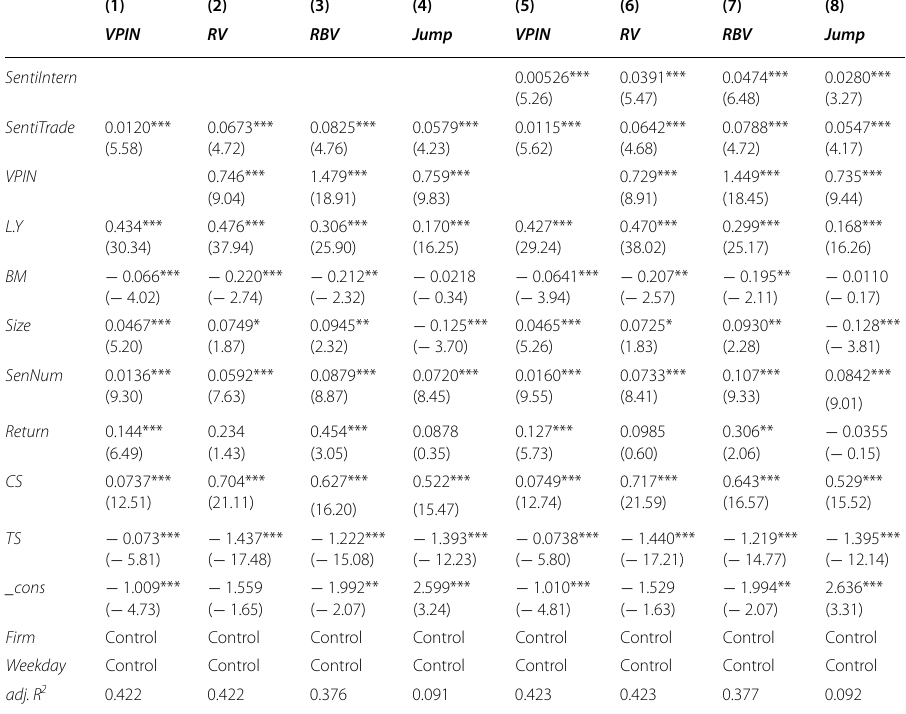
Table 7 Mediation effect model